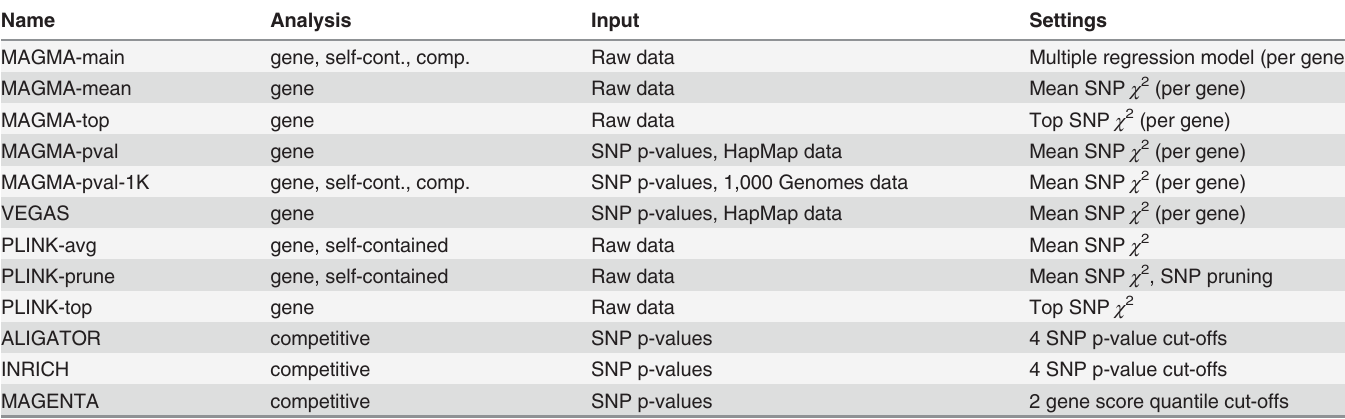
Table 1. Overview of Crohn ’ s Disease